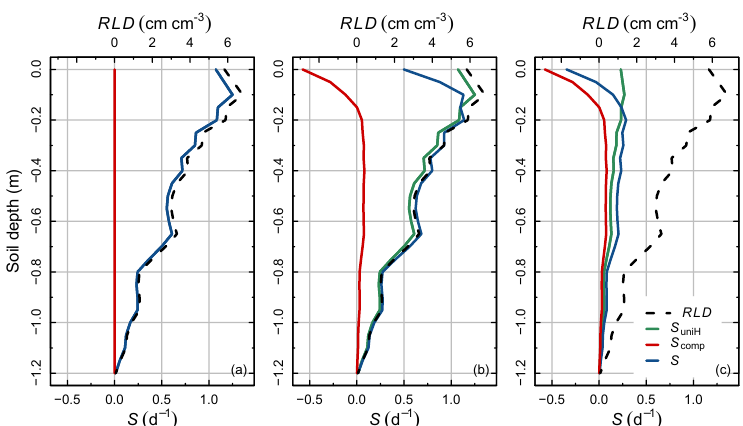
Figure 1. Some examples of root water uptake sink term ( S , in d − 1 ) profiles (blue lines) conceptualized as the sum of S uniH (green lines), the root water uptake term proportional to root length density RLD (dotted black line) and the compensatory root water uptake ( S comp , red lines). (a) S comp = 0 (no root compensation) leading to S = S uniH . (b) S comp (cid:54)= 0 and becomes negative towards the surface but remains smaller (in absolute terms) than S uniH . (c) S comp (cid:54)= 0 and is negative at the surface, while it is greater than S uniH for z > − 0 . 08m. In the last case, S is negative at the surface, meaning hydraulic lift is